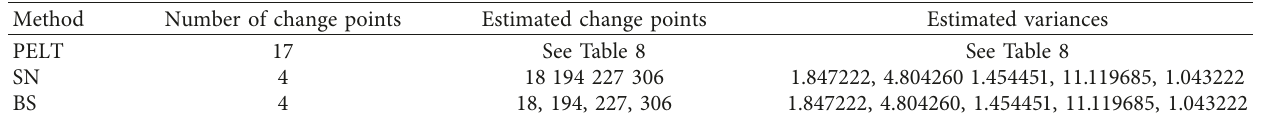
Table 7: Number of change points in the variance of maximum temperature.